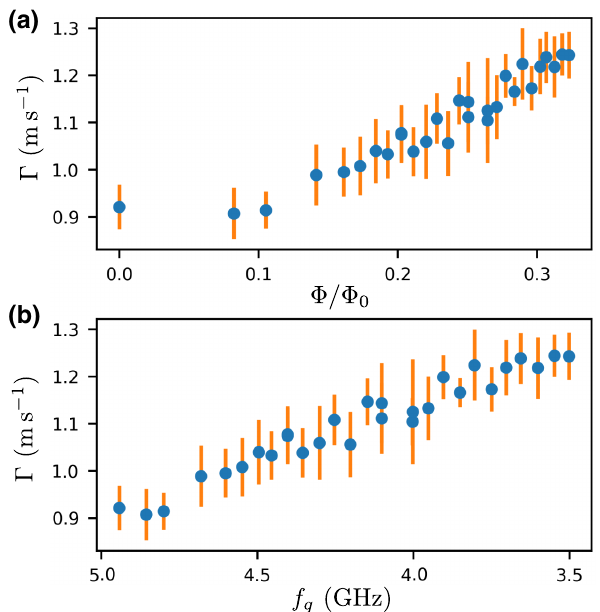
FIG. 16. (a) The parity-switching rate as a function of the flux for a device with 10 nm/100 nm thick electrodes. (b) The parity- switching rate as a function of the qubit frequency. We do not observe a sharp peak associated with the gap difference matching the qubit energy in this frequency